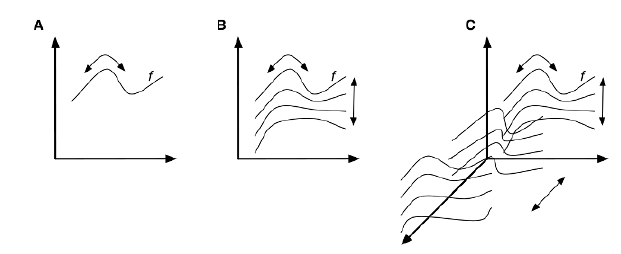
Figure 4. Changes at different dynamical scales: (A) single scale: values can vary only along f , (B) double scale: apart from changes along f , f can also be varied, and (C) triple scale: changes in ways in which f can be varied can also be explored. Note that these diagrams are only illustrative. f can certainly be multidimensional, i.e. in R n .